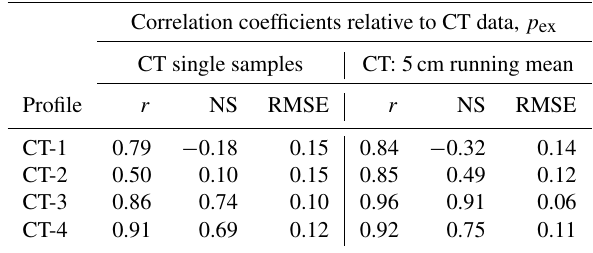
Table 5. Correlation coefficients between modeled anisotropy pro- files and CT anisotropy profiles as shown in Fig. 8. The first three columns are the correlation with respect to the individual anisotropy data points; the rightmost three columns are correlations with re- spect to the 5cm running mean of the CT-measured